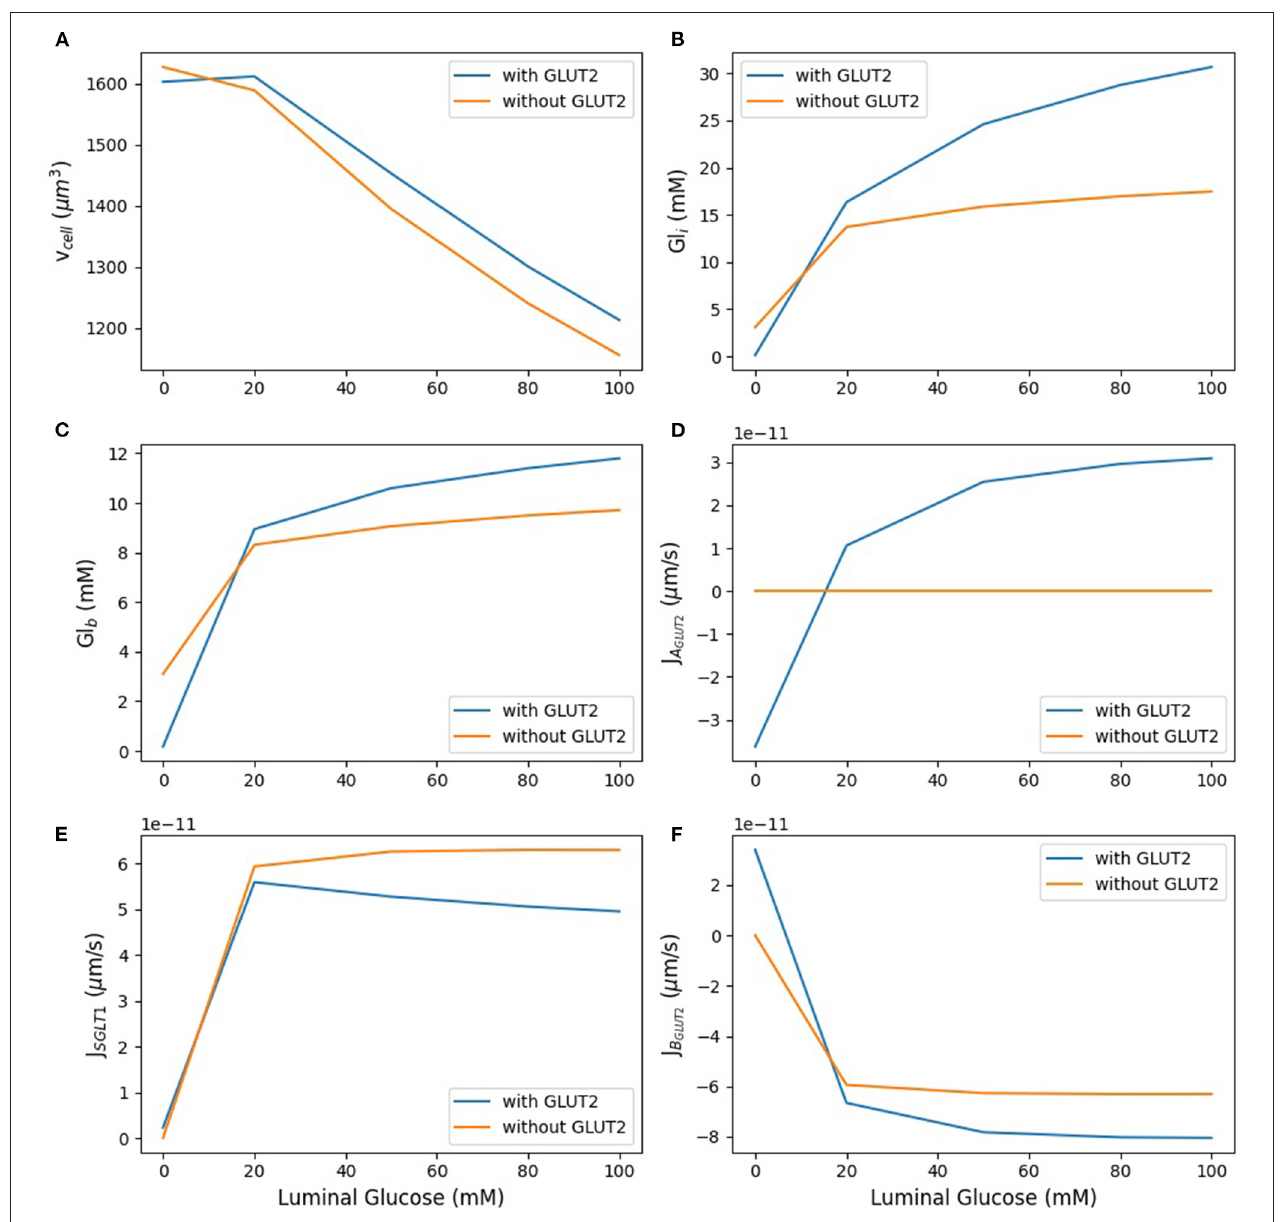
FIGURE 5 | Model response to different luminal glucose concentration. (A) Cell volume; (B) intracellular glucose; (C) blood glucose; (D) apical GLUT2 flux; (E) SGLT1 flux; (F) basolateral GLUT2 flux. The simulation was run under five different luminal glucose concentration (0, 20, 50, 80, and 100 mM). Simulation parameters: number of apical GLUT2 = 10 8 , number of basolateral GLUT2 = 2 × 10 8 , number of SGLT1 = 3 × 10 7 , inflow blood glucose = 4 mM, inlet blood flow rate = 10 − 17 m 3 /s, and blood volume = 10 − 16 m 3 .